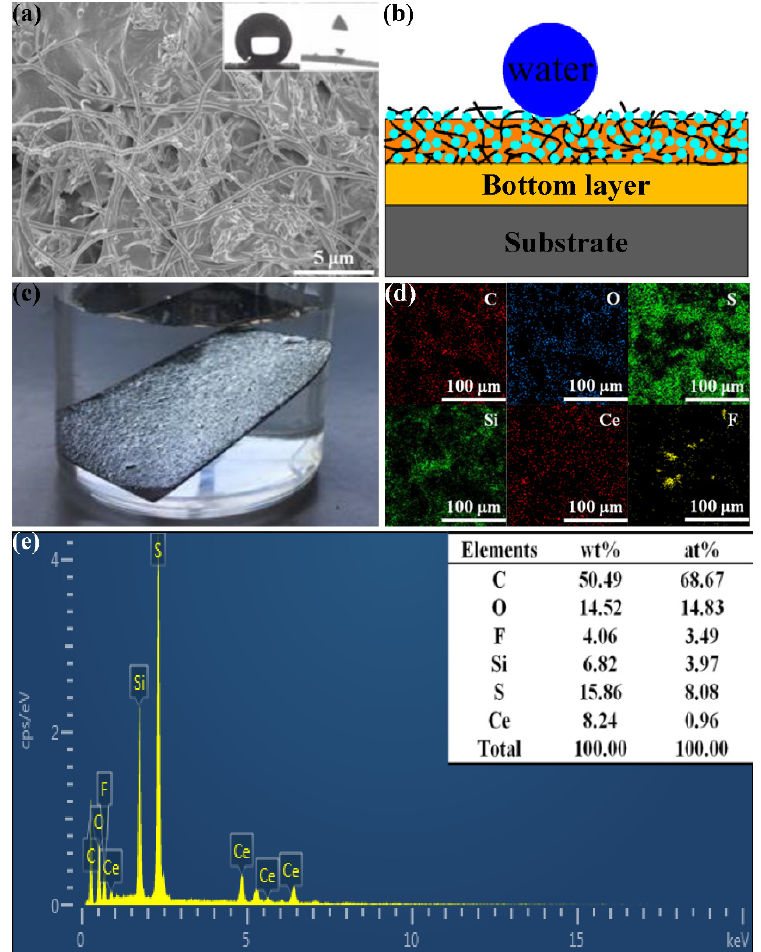
Figure 3. ( a ) SEM images of the CSC coating (insets are the WCA and SA). ( b ) Schematic diagram of superhydrophobicity on the CSC coating surface. ( c ) Silver mirror effect of the CSC coating. ( d ) Element distribution on the CSC coating surface. ( e ) The EDS spectrum of the prepared CSC coating [33]. Reprinted from Ref. [33].